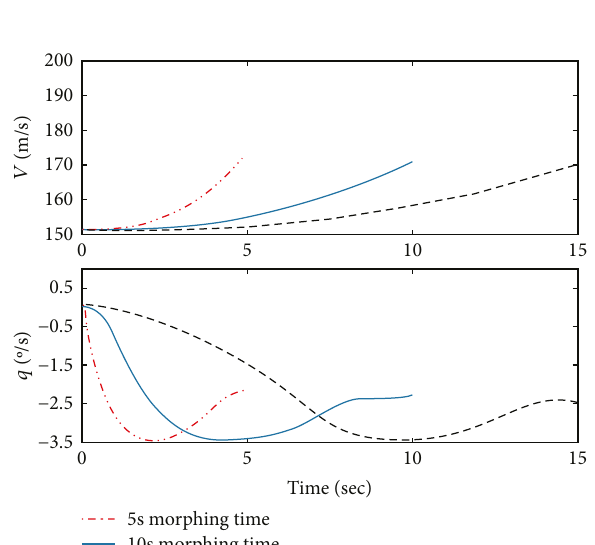
Figure 5: Aerodynamic coe ffi